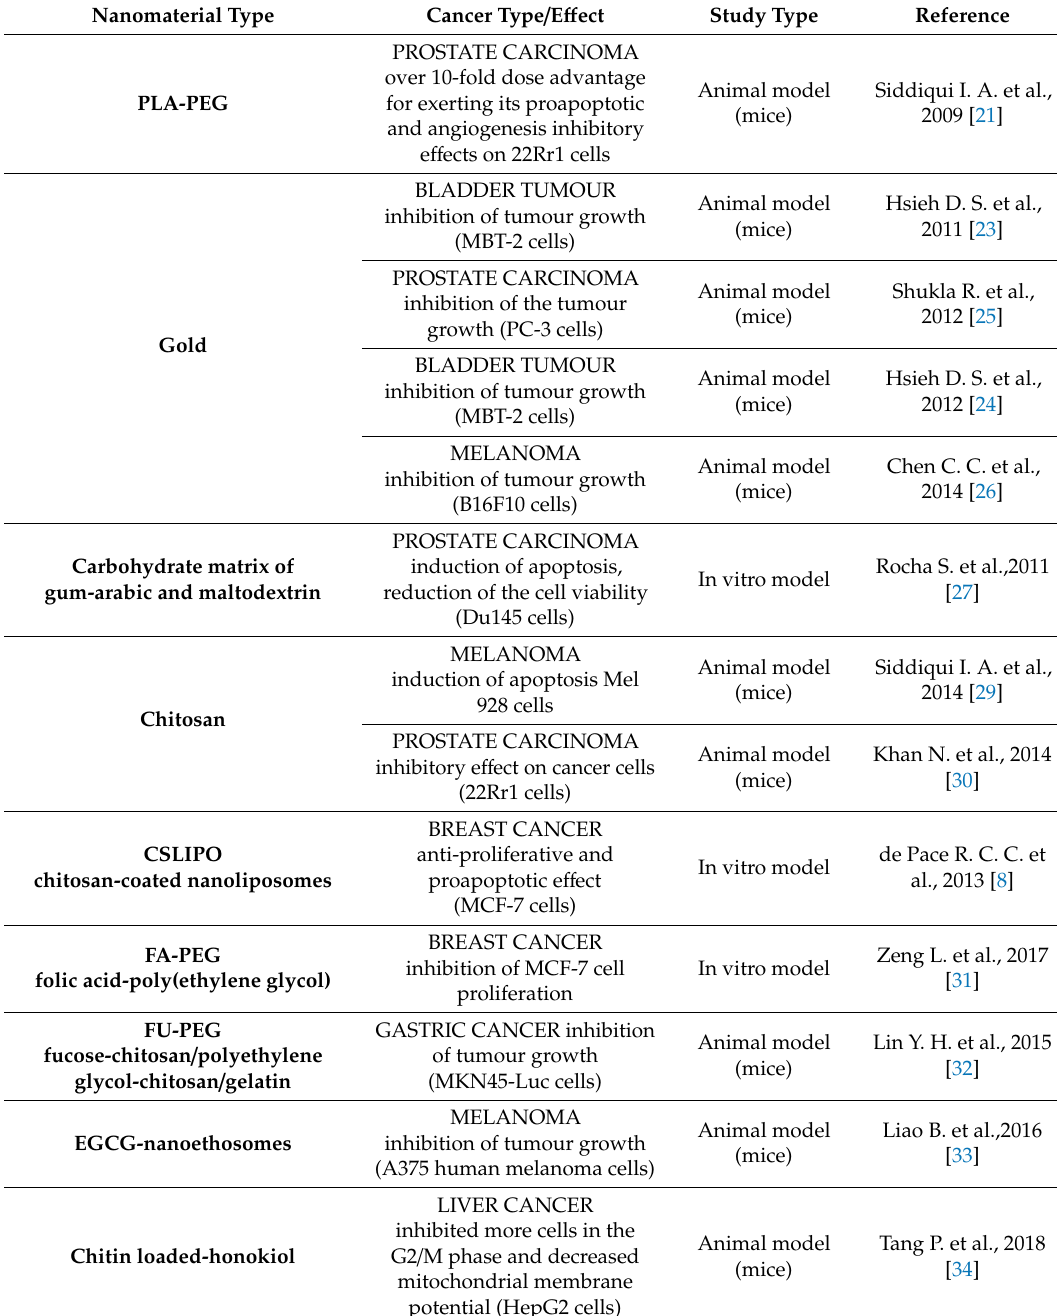
Anticancer e ff ect of epigallocatechin-3-gallate (EGCG) nanoparticles in in vitro and in vivo